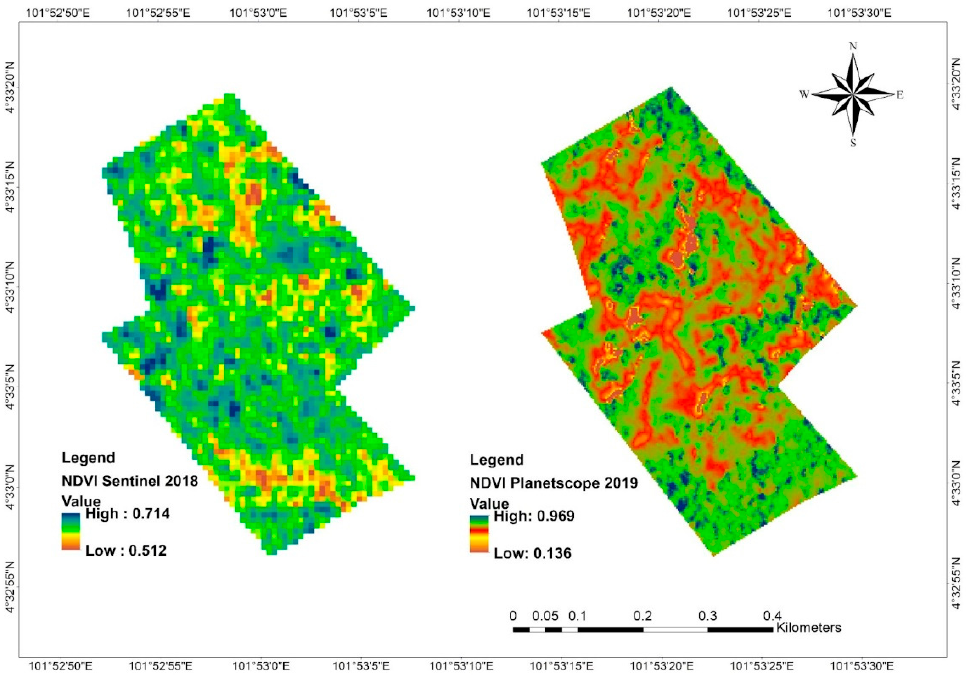
Figure 6 . NDVI map between the years 2018 and 2019 . Figure 6. NDVI map between the years 2018 and